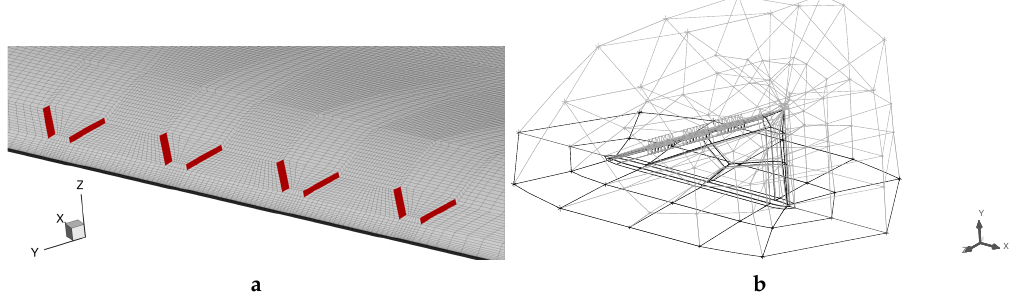
Figure 3. Computational grid: ( a ) detail view of the leading-edge surface mesh and ( b ) O-grid blocking.